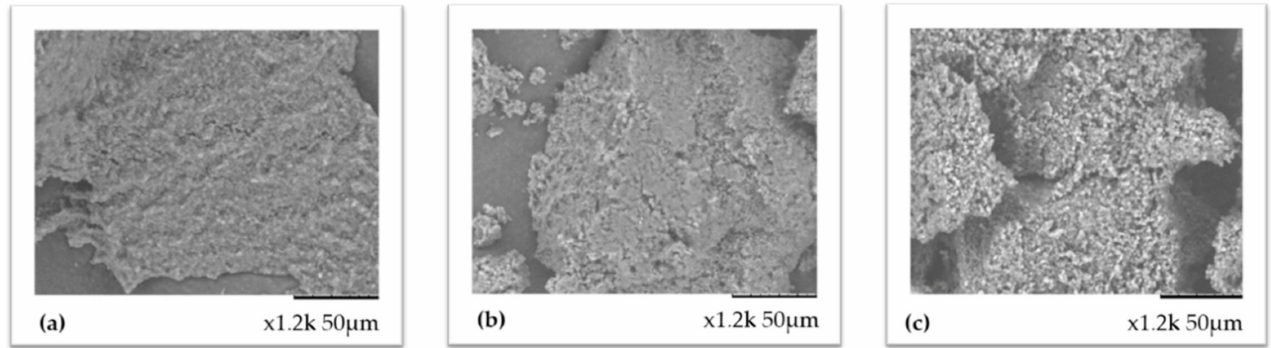
Figure 8. Nannochloropsis biomass analysis using SEM: ( a ) Initial time; ( b ) ultrasound pretreatment using US bath Elmasonic S 40H at 37 kHz for 6 h at 55 ◦ C without enzymes; ( c ) combined US-assisted enzymatic pretreatment using US bath Elmasonic S 40H at 37 kHz for 6 h and 55 ◦ C in combination with Alcalase, Viscozyme, and Celluclast commercial enzymes